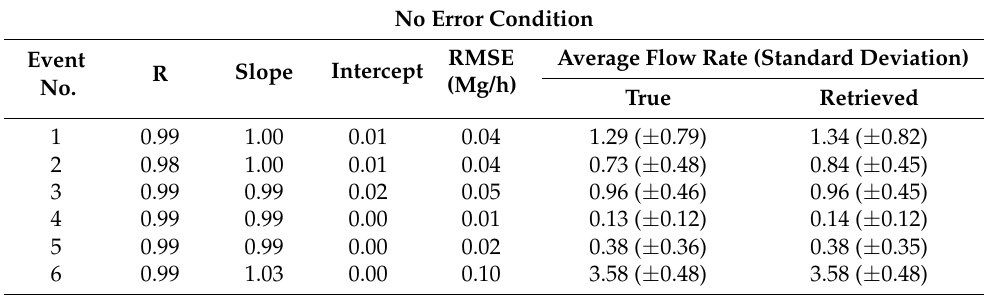
Figure 16. Correlation between the true and retrieved SO 2 flow rates under the conditions of no errors in both the GEMS SO 2 retrieval and wind data for each event in Table 1. Table 3. Statistical analysis of the true SO 2 flow rates and those calculated under the presence of no errors in the SO 2 retrieval and no uncertainty in wind